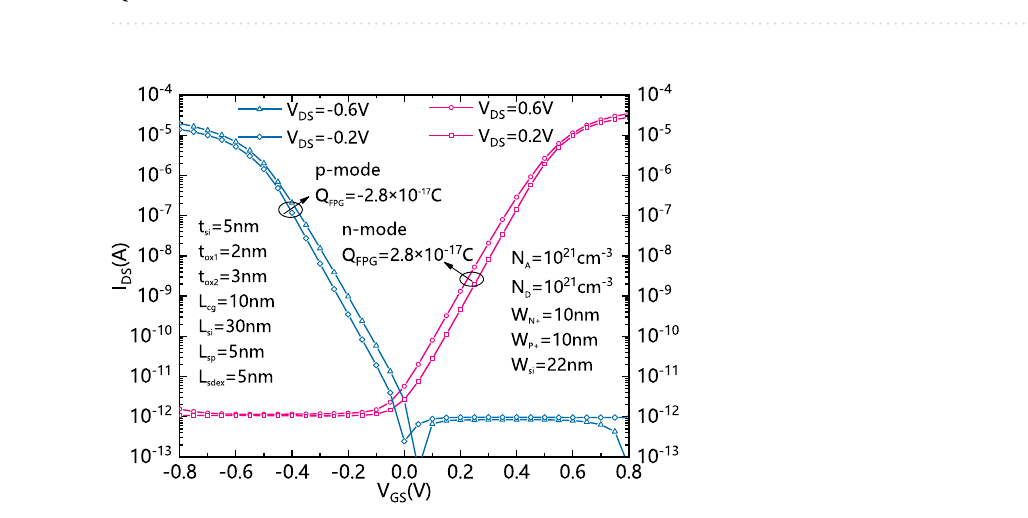
Figure 6. ( a ) The variation of the VFPG with different QFPGs and VGSs; ( b ) the variation of △ V with different QFPGs andVGSs.